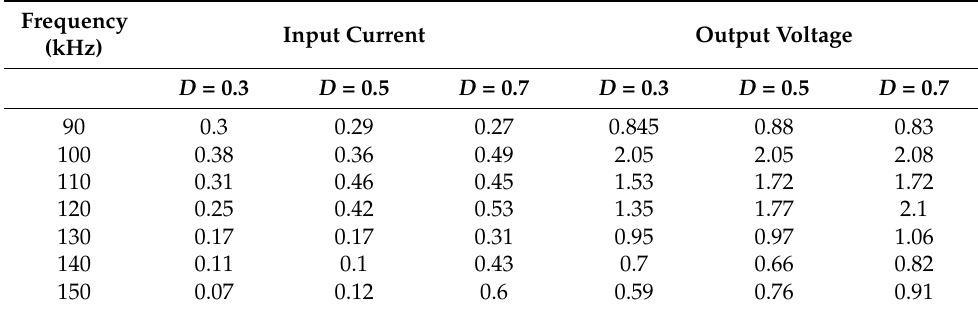
Table 2. Hardware results for various duty cycle and frequencies.